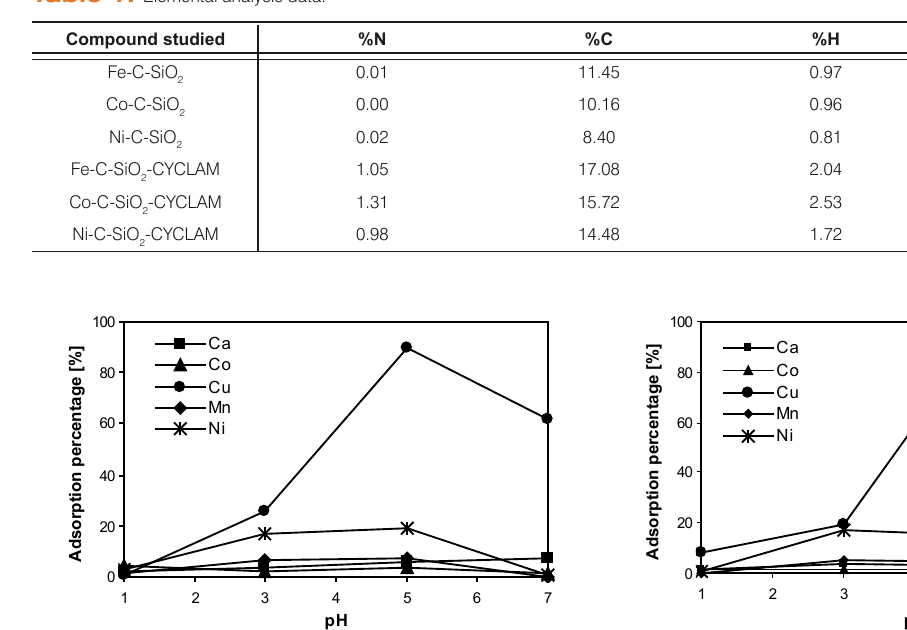
Figure 3. Effect of pH solution on the adsorption percentage of Ca, Co, Cu, Mn, Ni ions by the support 2 .